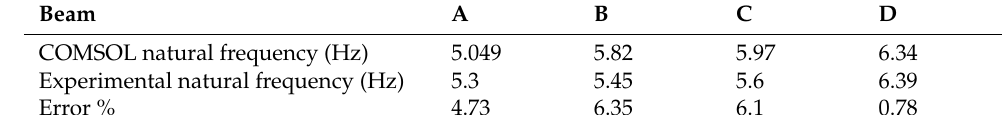
Table 3. Comparison between the natural frequency of FEA COMSOL and natural frequencies calculated experimentally by Ref. [12].